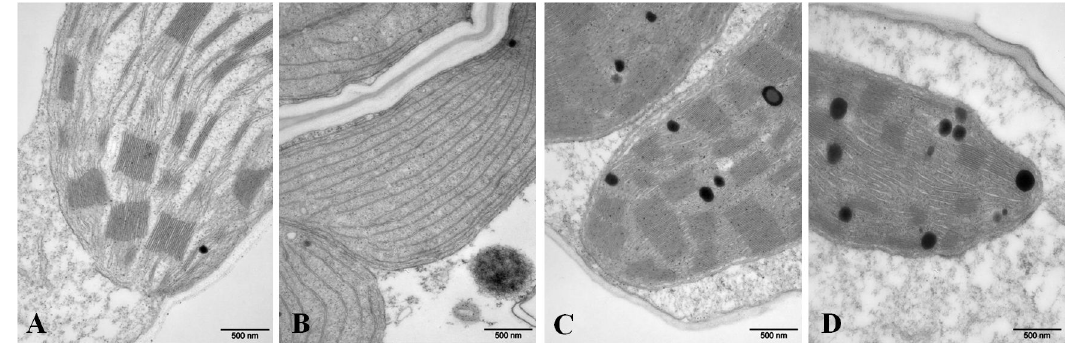
Figure 4. Electron microscope images of chloroplast structures. A and C, Zheng58 wild-type plants at the seedling and tasseling stages, respectively; B and D, elm2 mutant plants at the seedling and tasseling stages, respectively. Scale bar=500 nm.